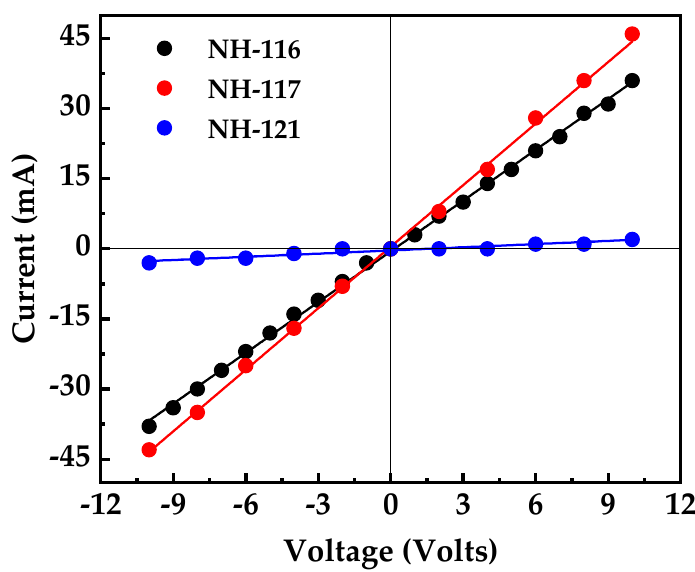
Figure 7. I-V measurements of the fabricated films. Figure 7. I–V measurements of the fabricated